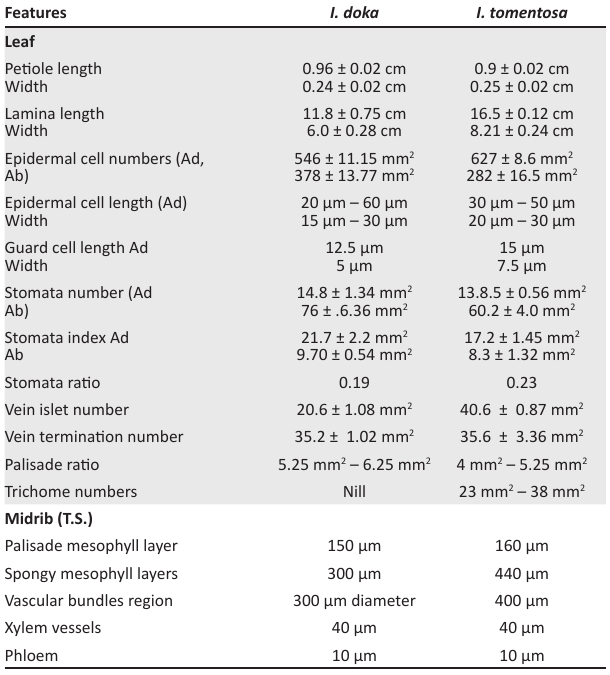
TABLE 4: Quantitative studies of I. doka and I. tomentosa leaves and stembark.